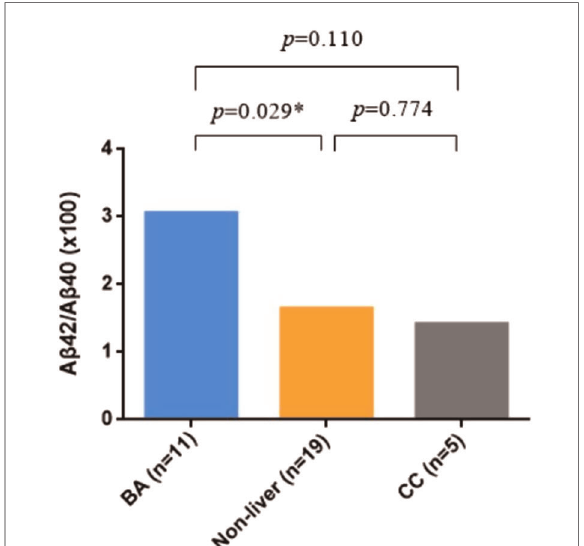
FIGURE 1 Expression level of plasma A β 42/A β 40 ratio in biliary atresia (BA) vs. non-BA. Mann – Whitney test was performed for A β 42/A β 40 ratio in different groups, showing that it was signi fi cantly elevated in BA patients.